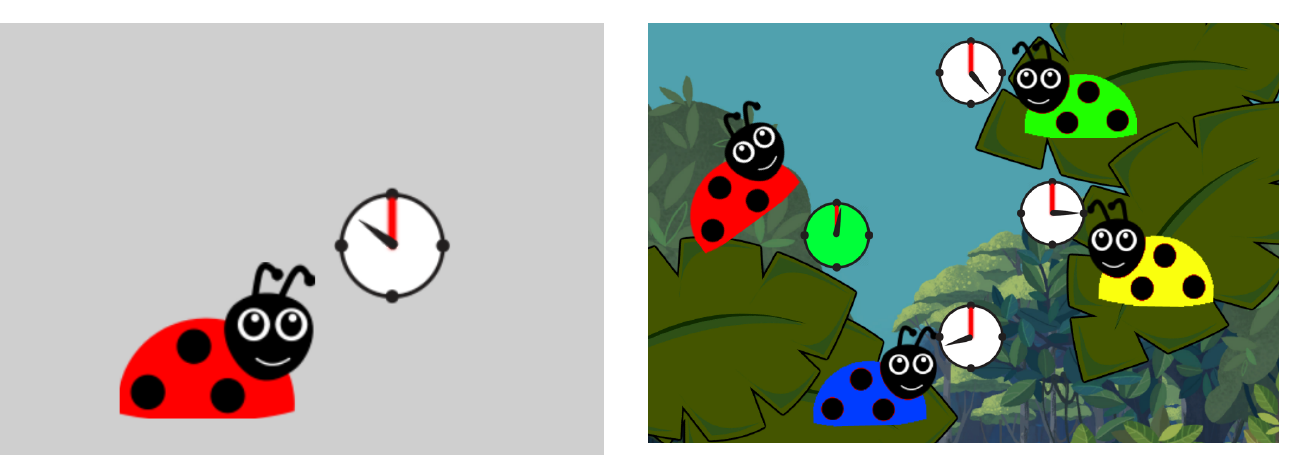
Fig. 2. The figure shows a red ladybug and its associated clock during a One Switch Demo game.